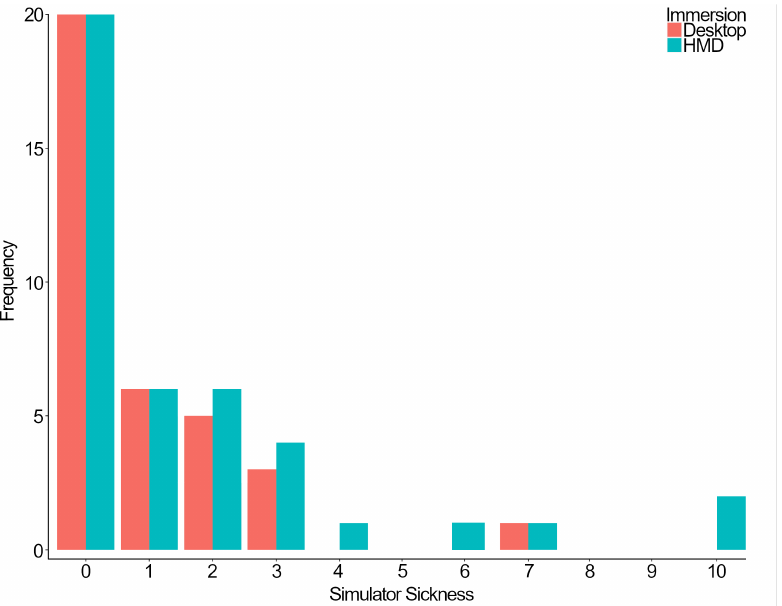
Figure 6. Total count of simulator sickness symptom severity responses in the FMS